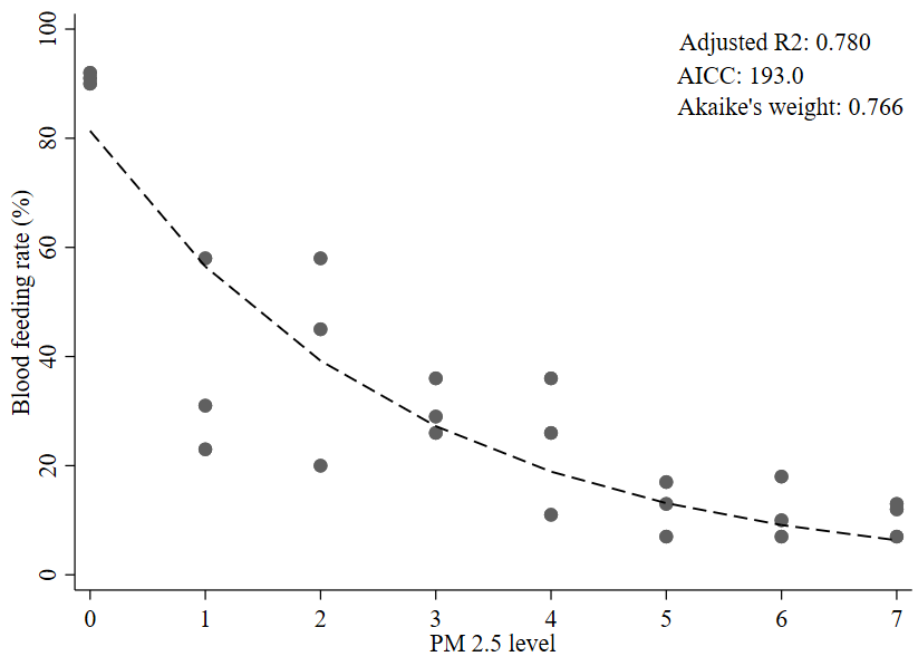
Figure 1. Exponential decay model of the dose–response relationship between PM 2.5 level and blood-feeding rate in female Ae.aegypti mosquitoes.